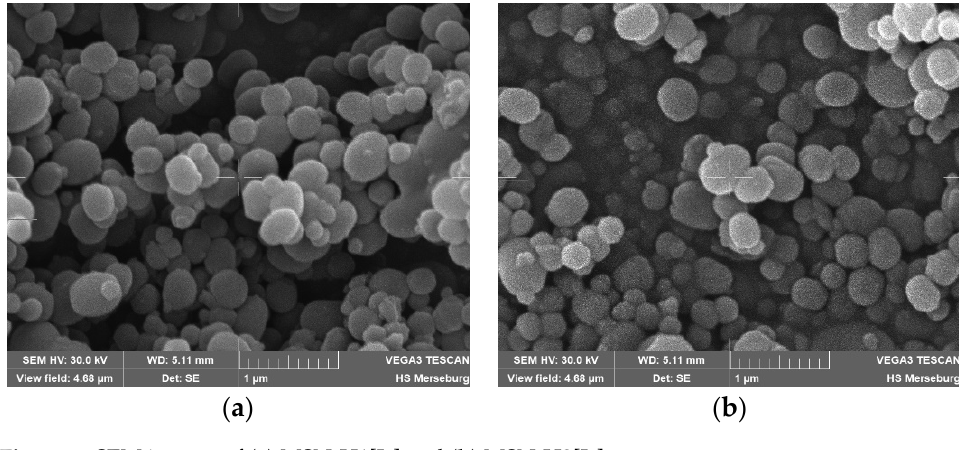
Figure 1. Schematic representation of functionalization of MSN with ligands (H1 and H2), and